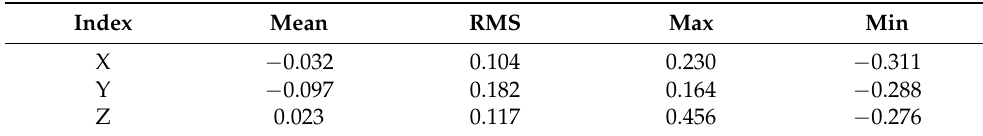
Figure 13. Positioning residuals distribution of TH-1 HR camera after geometric calibration. ( a ) Positioning residuals in the XY planar direction; ( b ) Positioning residuals in the elevation direction. Table 13. Ground coordinate differences statistics of the corresponding image points after geometric calibration. (Unit: meter).